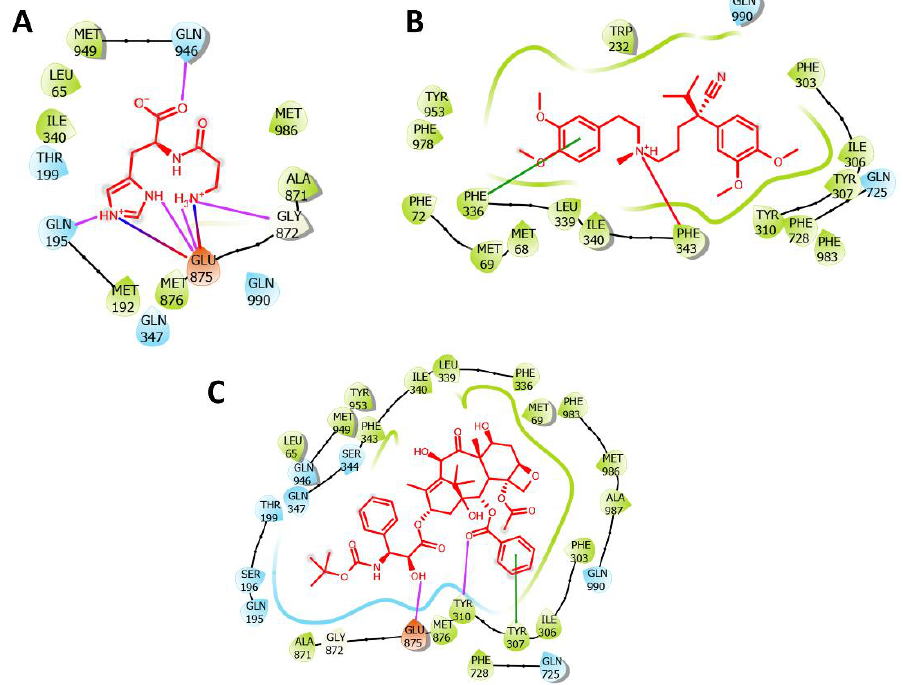
Figure 4. The ligand interactions of carnosine, verapamil, and co-crystalized ligand (paclitaxel) with P-glycoprotein (P-gp). ( A ) Carnosine docking site with P-gp. ( B ) Verapamil docking site with P-gp. ( C ) Paclitaxel docking site with P-gp. Hydrogen bonds are shown in purple, stacking interaction in green, and salt bridges in multicolored sticks.